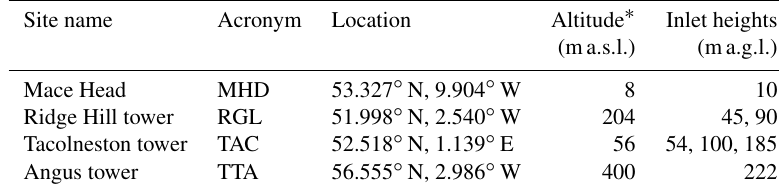
Table 2. Site names, locations and inlet heights.